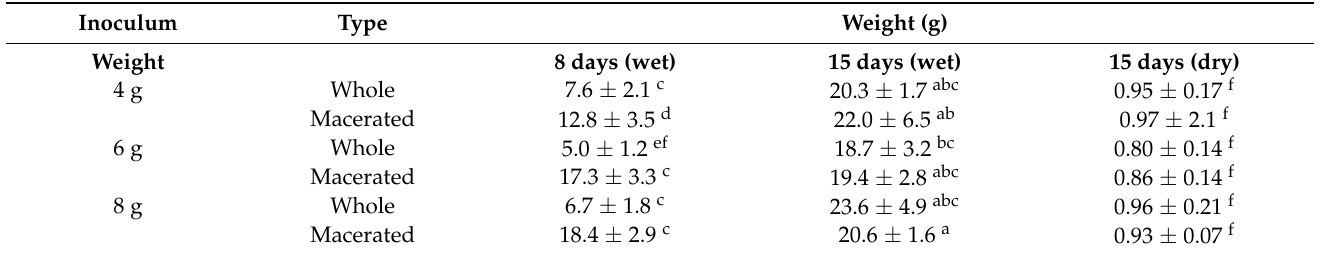
Table 1. Wet and dry weights of nascent pellicles after inoculation with 4, 6, or 8 g (wet weight) of macerated or whole Toby mother